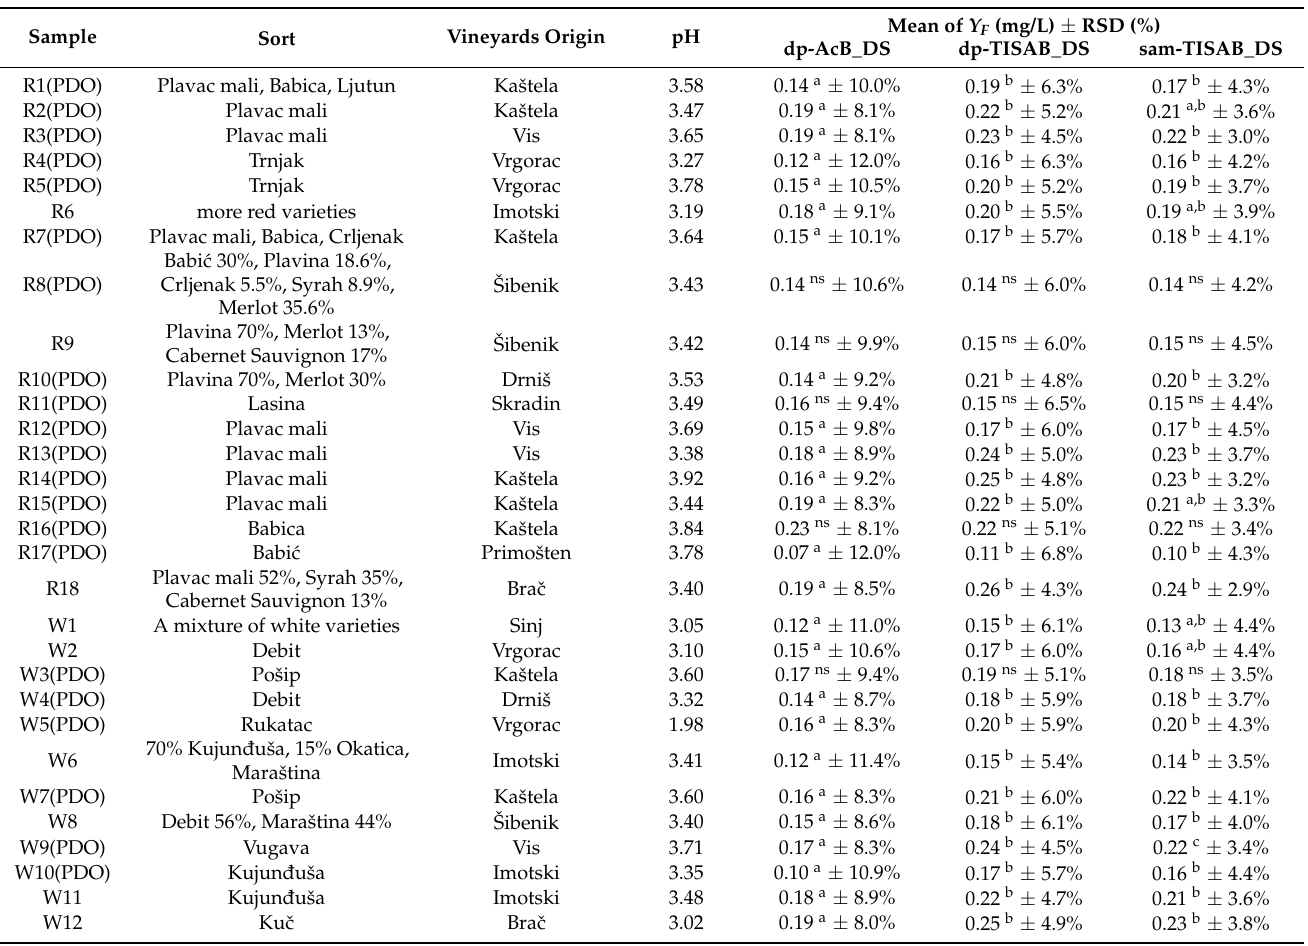
Table 1. A list of wine varieties, regions of origin, pH values and fluoride contents determined by direct potentiometry and the standard addition method in TISAB_DS, i.e.,